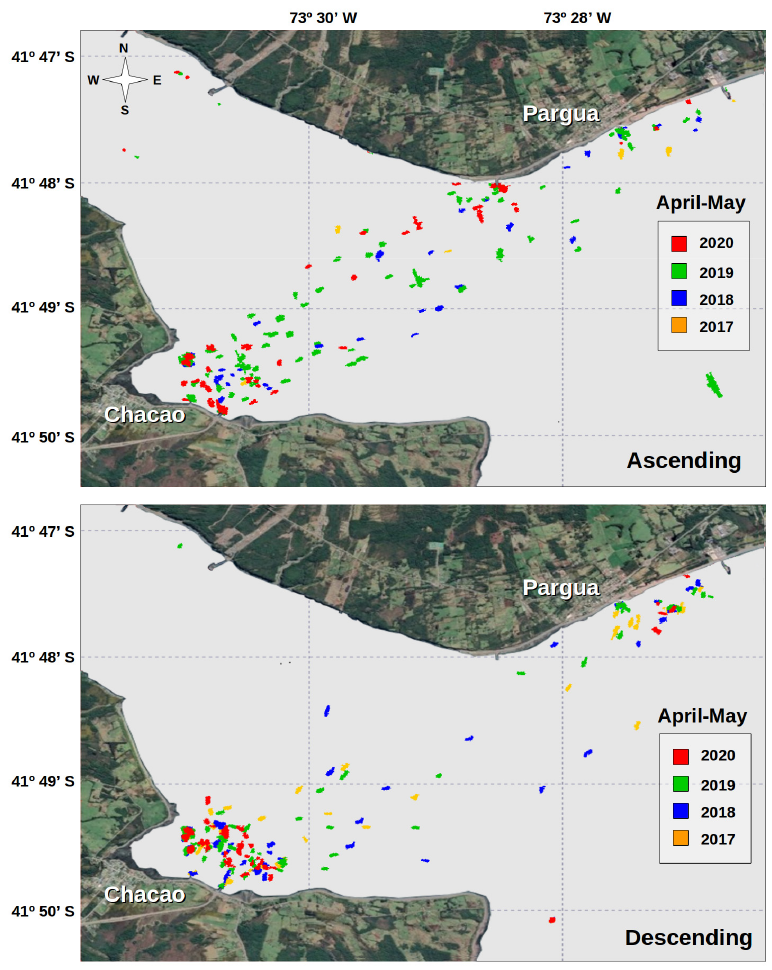
Figure 4. Maps based on the Sentinel-1 images analyzed in the Chacao Channel during April and May for the study period 2017–2020. Different colors represent the results by year for ascending passes (upper panel) and descending passes (lower